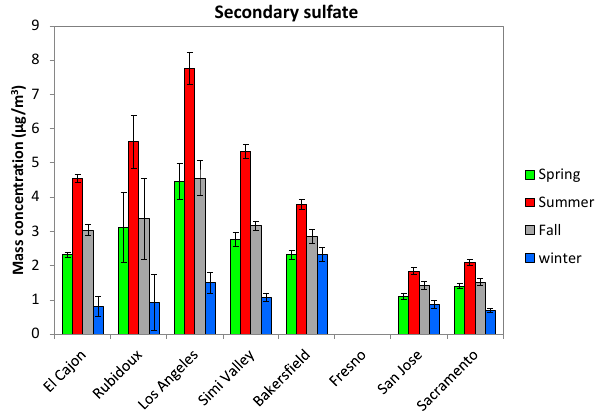
Figure 3. Seasonal average source contribution (µg/m 3 ) of secondary ammonium nitrate to ambient PM 2.5 , by site. Error bars correspond to one standard error.